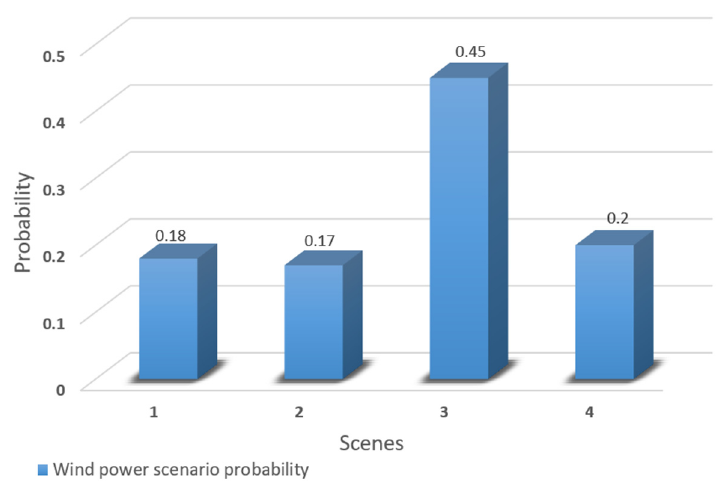
Figure 5. The probability corresponding to each wind power classic scene.